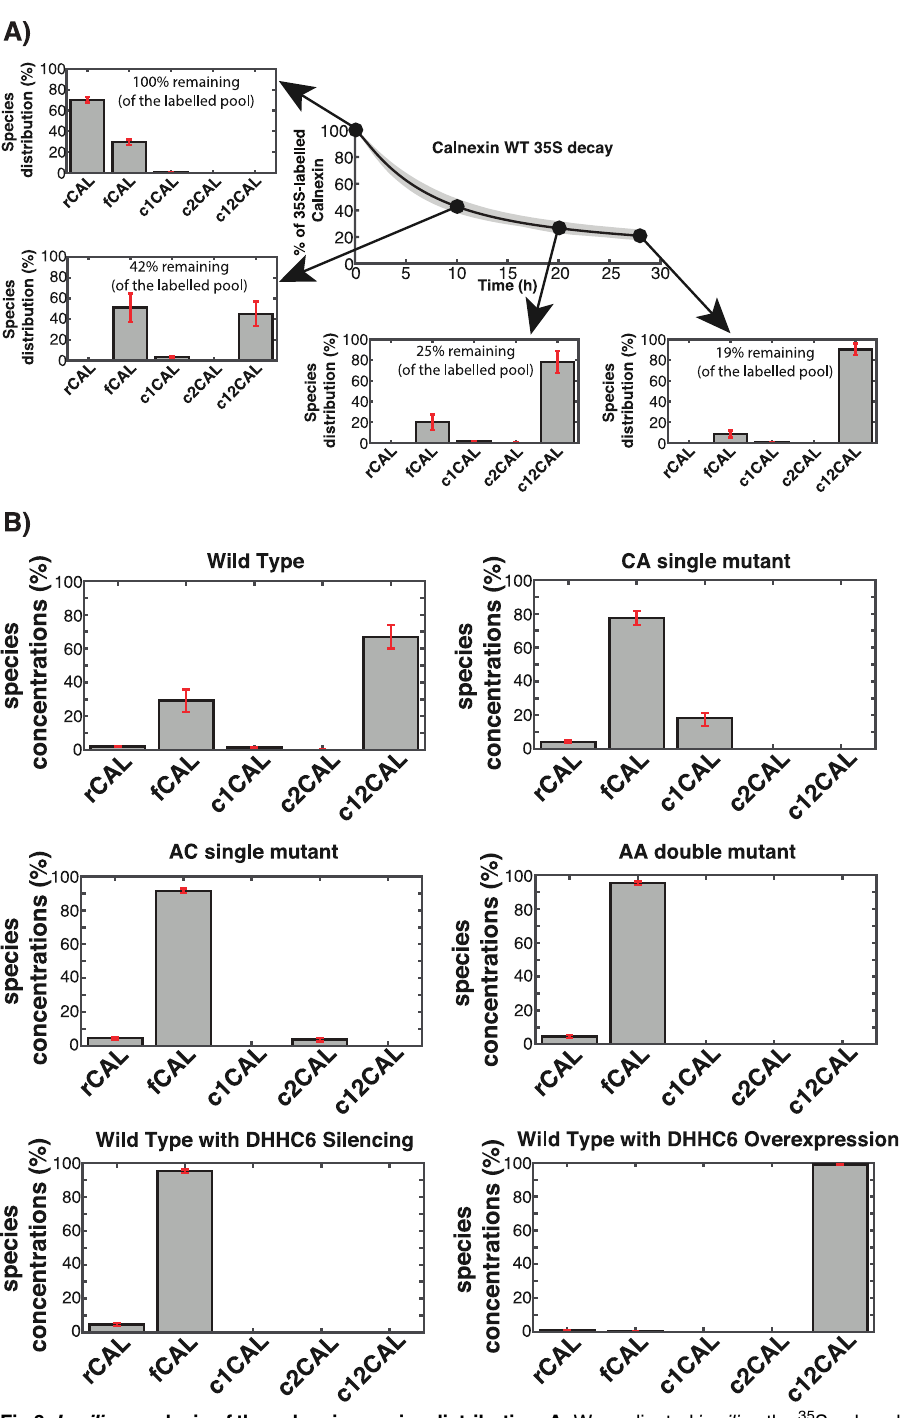
Fig 3. In silico analysis of the calnexin species distribution. A: We replicated in silico the 35 S pulse-chase experiment on WT calnexin. During the experiment we monitored the relative distribution of calnexin in the different palmitoylation states. Solid line is the mean of the simulations of 382 models; error bars are defined by the first and the third quartile of the simulations of 382 models (details of the in silico labelling experiment can be found in the Expanded View). B: The model was used to predict the steady state distribution of WT calnexin and of the mutants in the cell. rCAL correspond to calnexin during the synthesis, fCAL represent folded calnexin while c1CAL and c2CAL denote the two single palmitoylated species. c12CAL represents the double palmitoylated calnexin. Error bars correspond to first and third quartile of the simulations of 382 models (details of the in silico labelling experiment can be found in the Supplementary